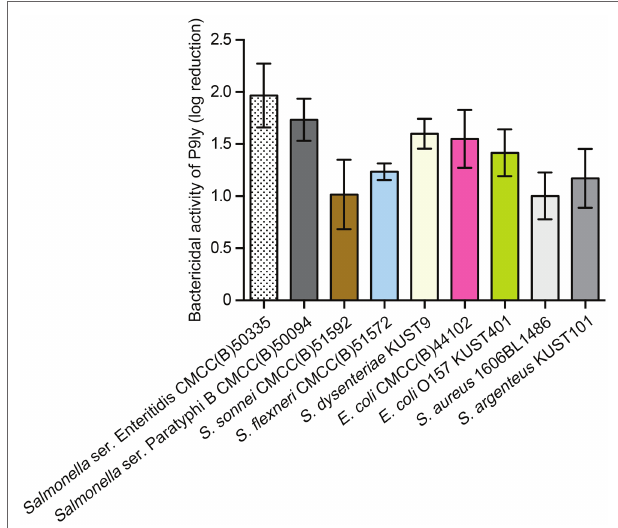
FIGURE 7 | Bactericidal activity of P9ly against different bacterial strains. Among them, Staphylococcus aureus (1606BL1486) and Staphylococcus argenteus (KUST101) are Gram-positive bacteria. Approximately 10 7 CFU/ml of different strains were treated with 75 μ g/ml (4.05 μ M) of P9ly at 37 ° C for 60 min, log kills were evaluated as the relative decrease in the viable counts of bacterial cell suspensions. All data were expressed as mean ± SD of three biological